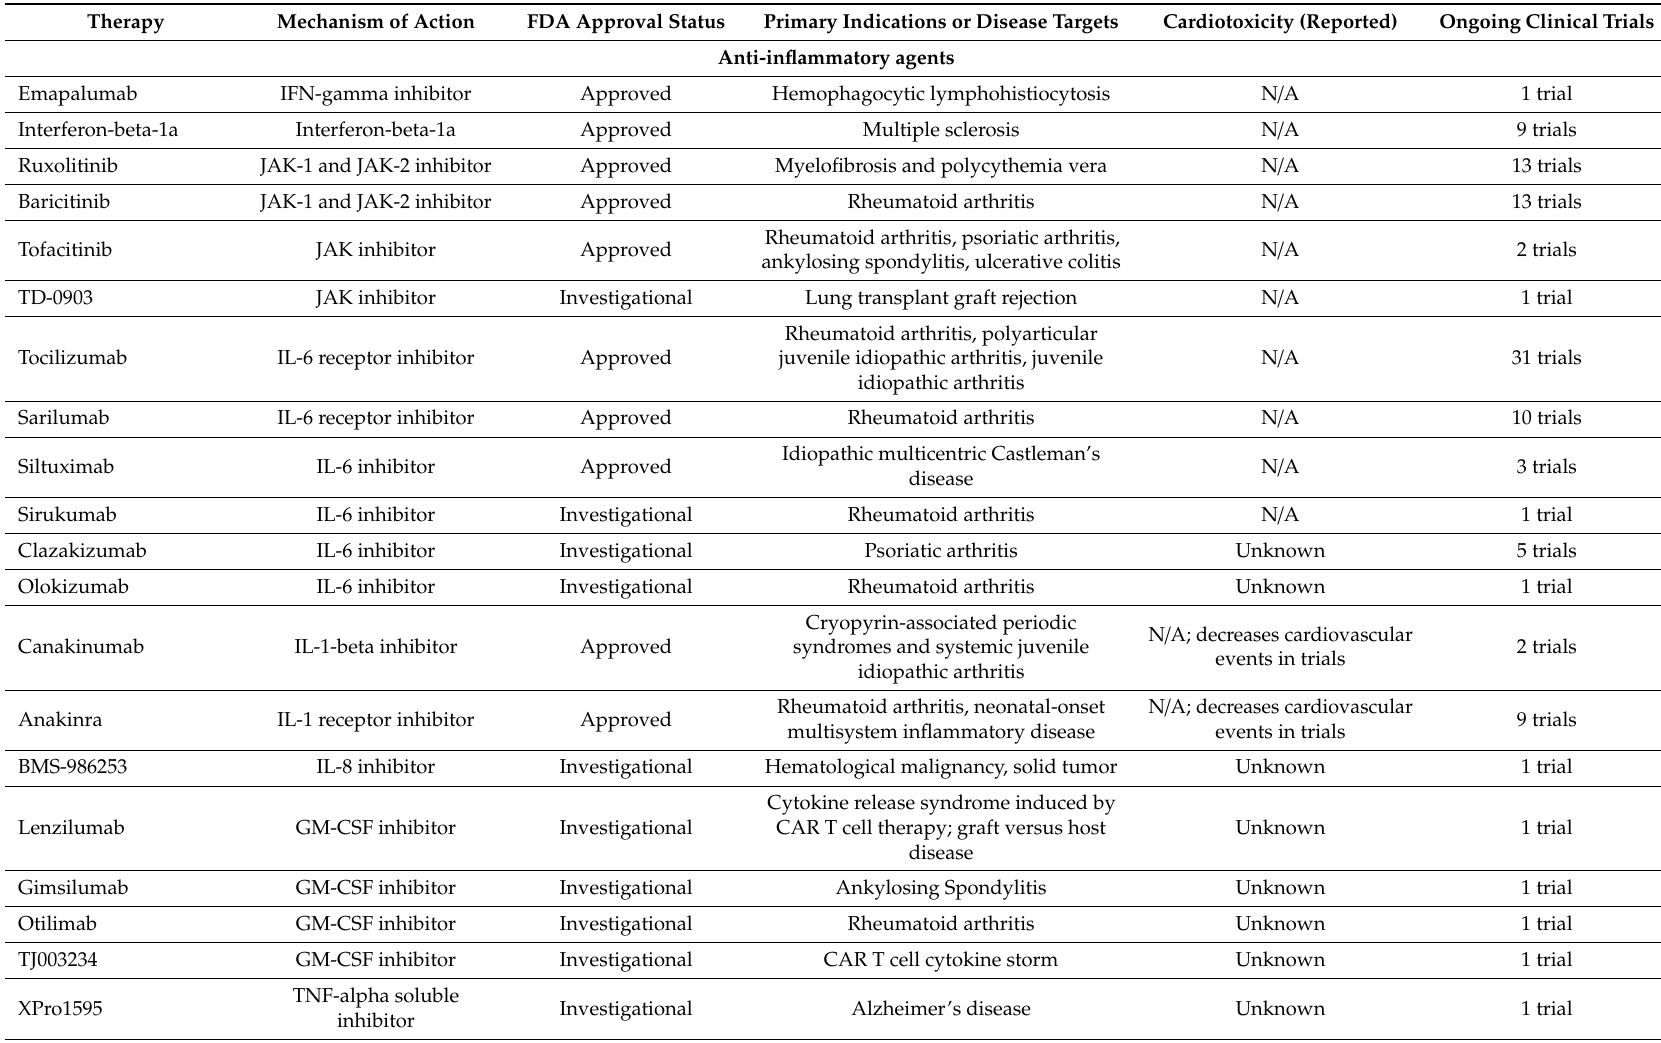
Table 1. Repurposed Immunomodulatory Therapies currently under evaluation in COVID-19 Clinical